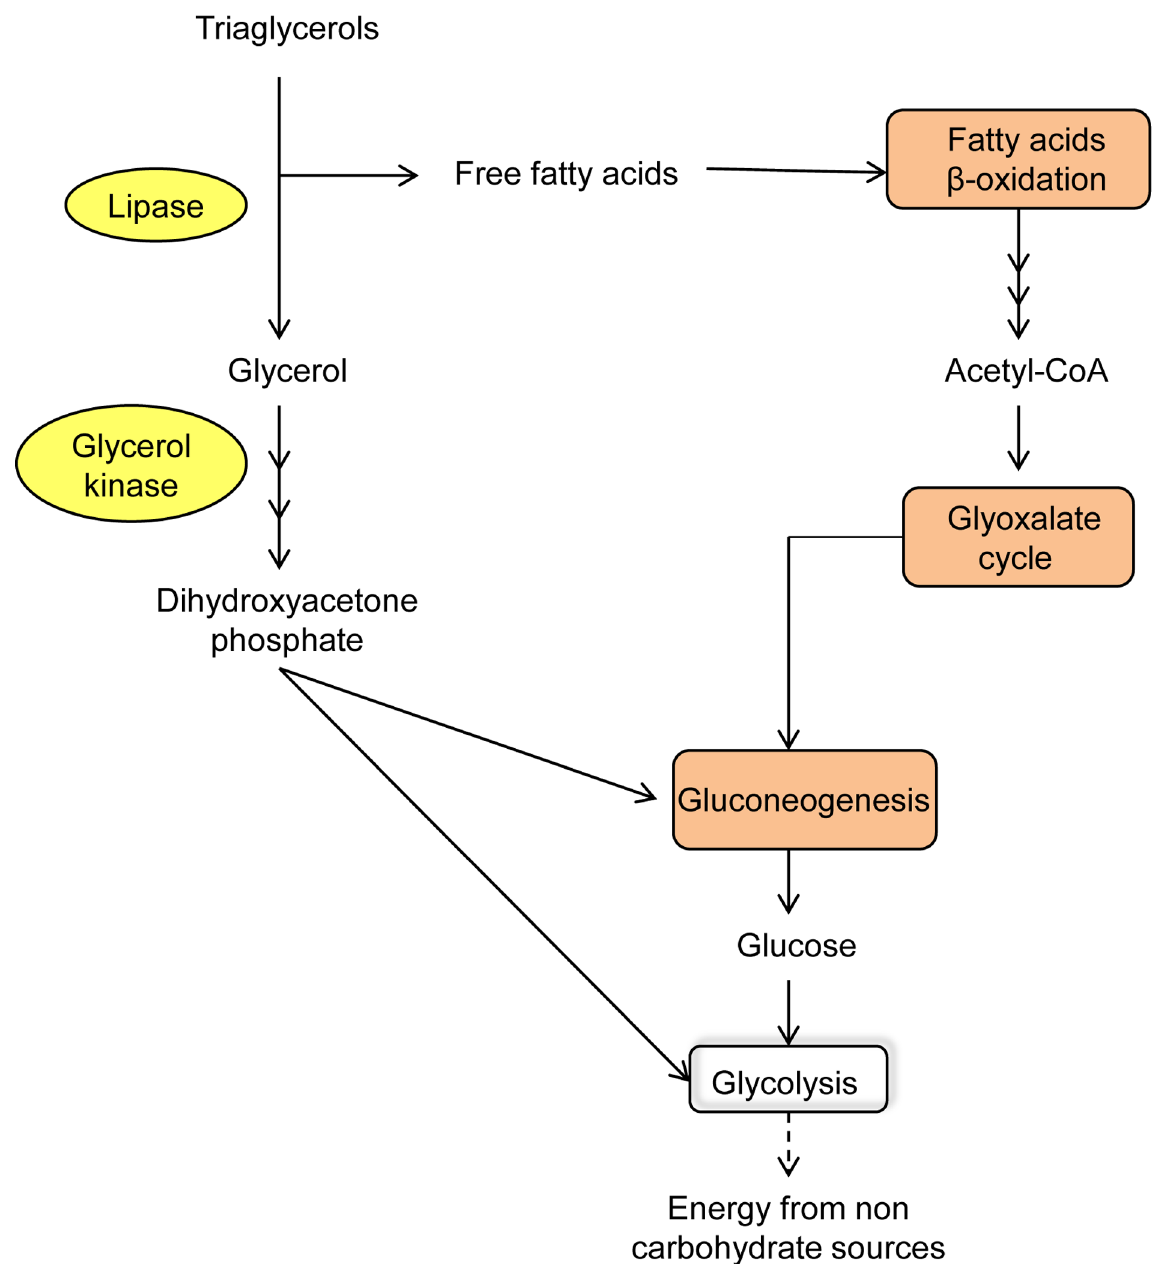
Figure 6. Metabolic processes in germinated spores. Metabolic processes or specific enzymatic activities overrepresented in spores identified by B2G analysis and manual annotation are highlighted in this cartoon. Orange boxes and yellow ovals are metabolic processes or particular enzymes that showed statistically significant upregulation in germinated spores.